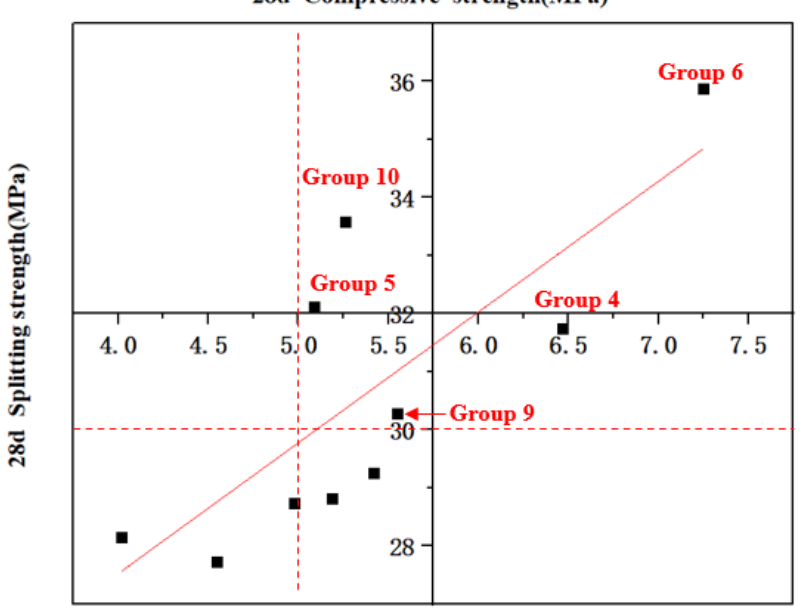
Figure 19. Axial scatter diagram of compressive strength and splitting strength.